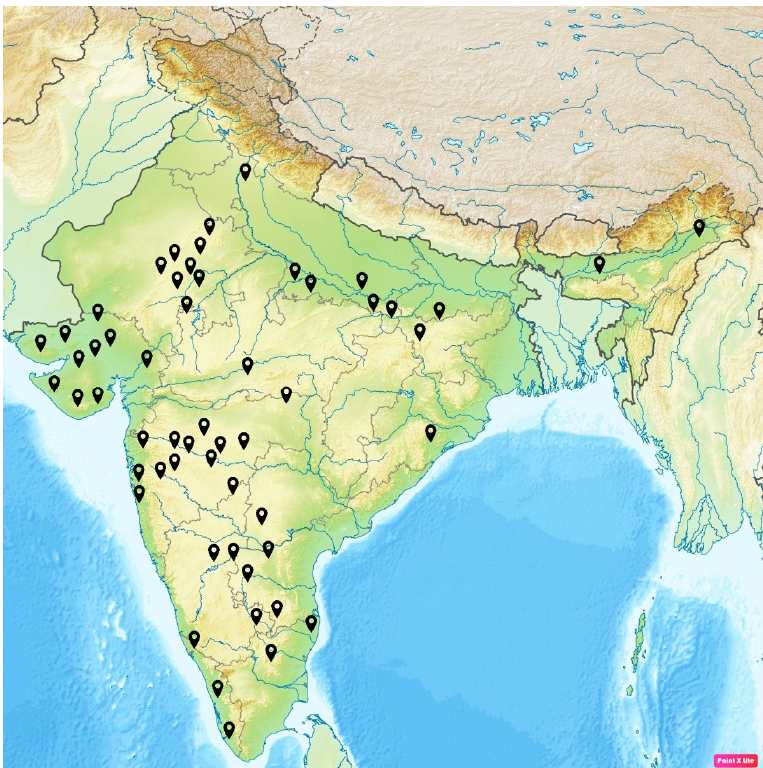
Figure 4. Distribution of stepwells across the Indian Subcontinent. White sign represents Madhya Pradesh and parts of Maharashtra. Blue sign represents Gujarat, Karnataka and Andhra Pradesh. Light Grey sign represents Jharkhand and Bihar.